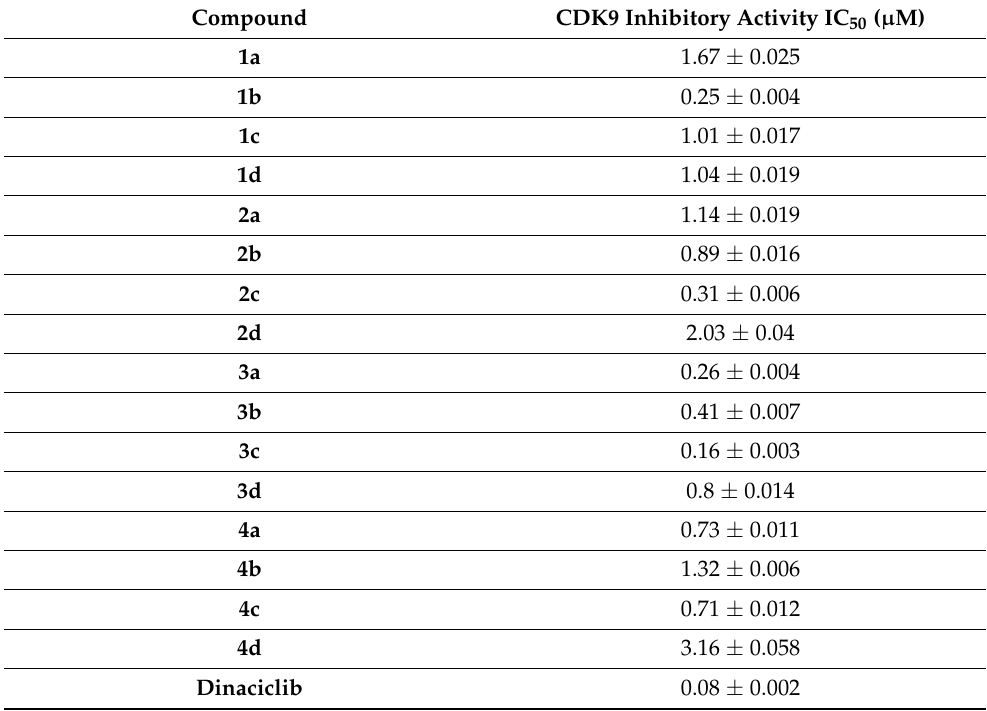
Table 1. CDK9 inhibitory activity in biochemical assay of compound 1a – 4d . Data are presented as mean ± standard deviation of three individual